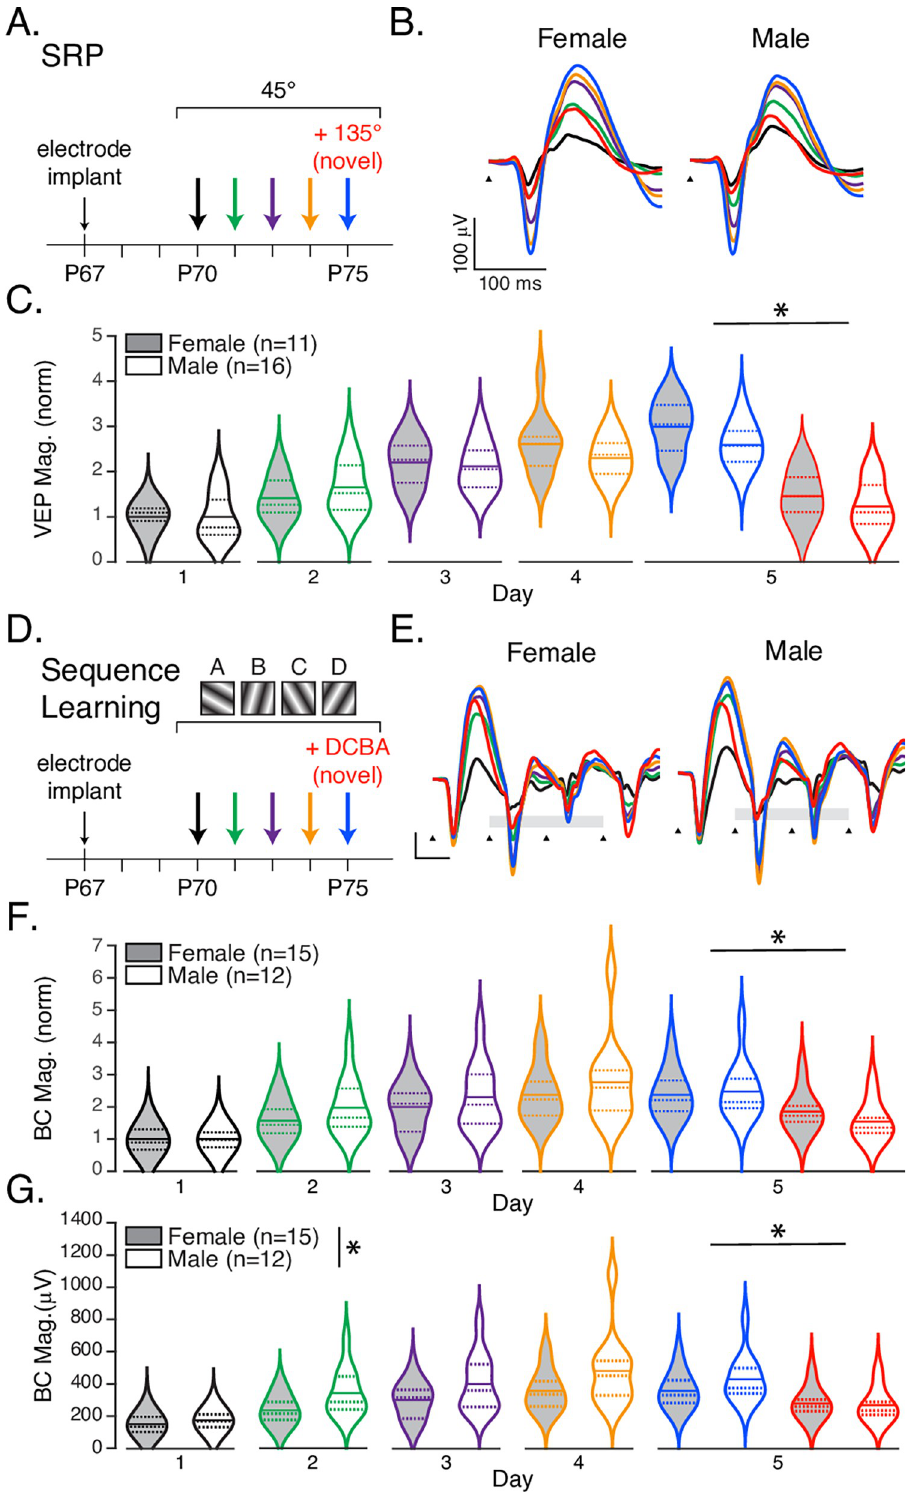
Fig 3. Sex can affect experience dependent plasticity. A. SRP experiment protocol. Animals were trained with repeated presentation of a 45˚ stimulus over five days. On the 5 th day, a novel stimulus (red, 135˚) was interleaved with the familiar stimulus (blue). B. Average VEP traces during SRP induction and expression in female and male mice,